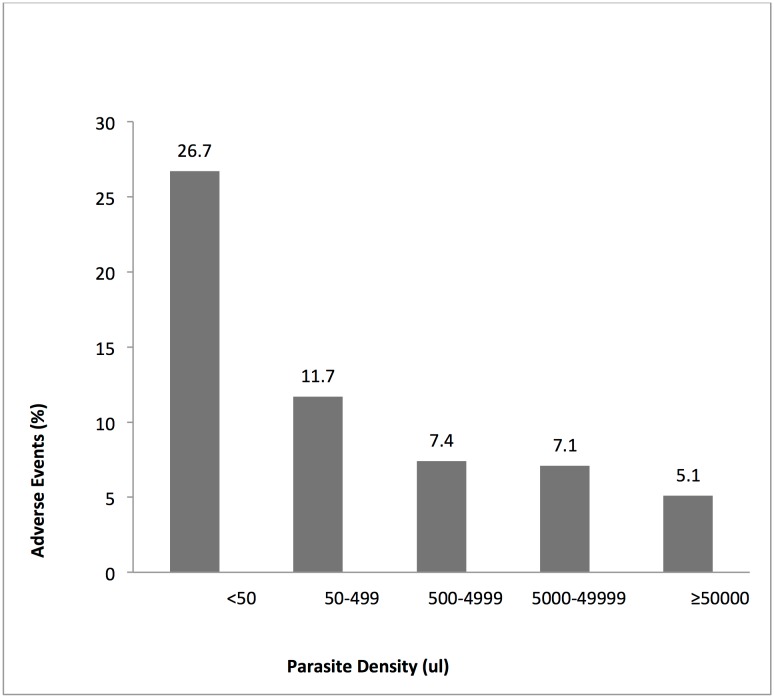
This figure shows a negative correlation between the incidence of reported adverse events and categories of malaria parasite density among the study participants.